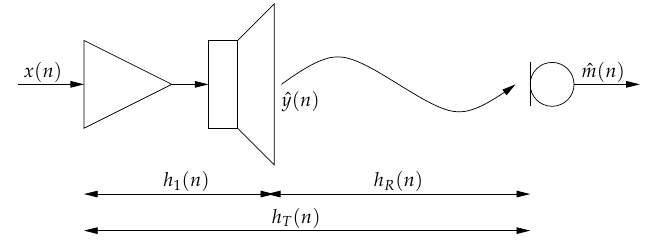
Figure 1. The measurement